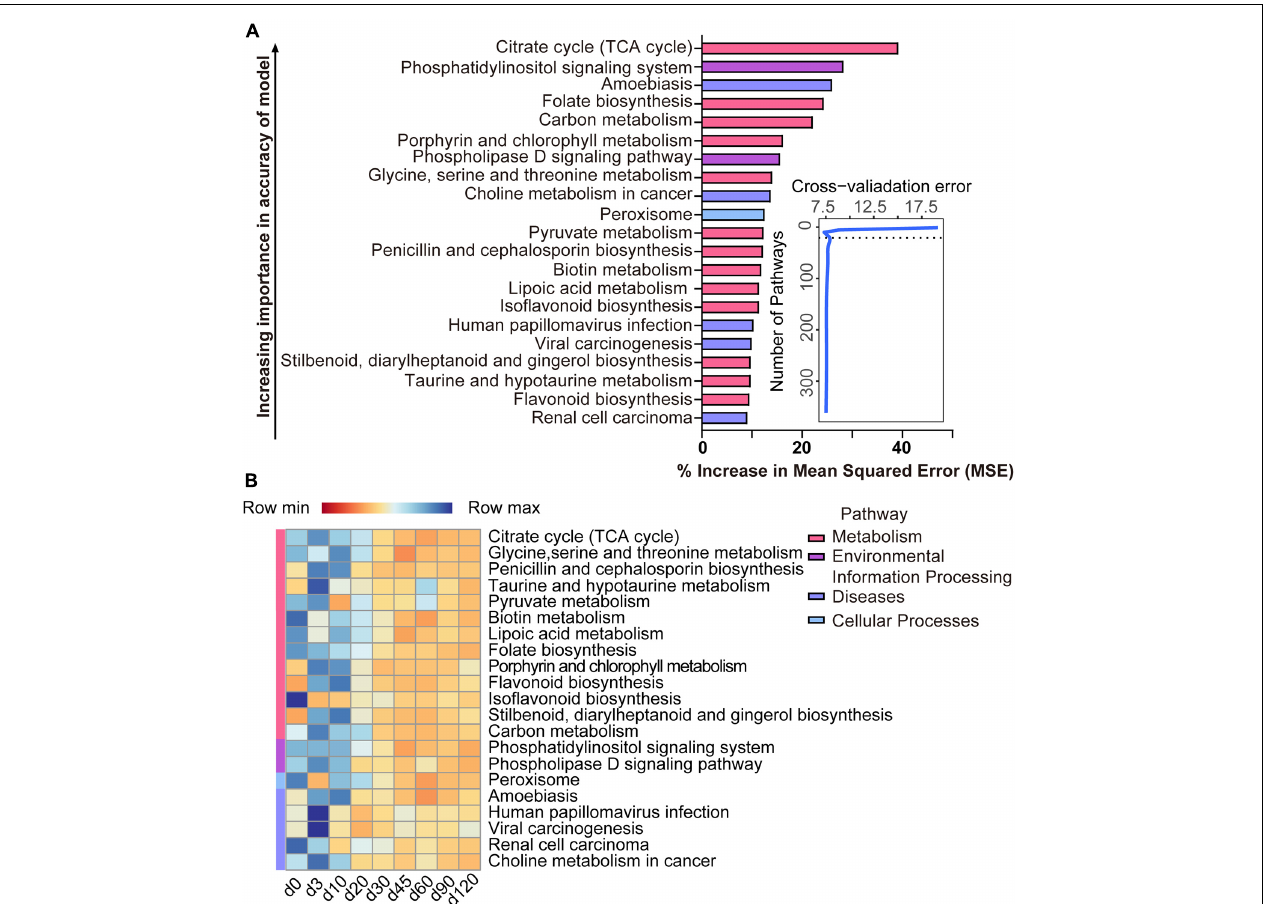
FIGURE 6 | Bacterial pathway biomarkers of lamb age and the rumen microbiota gradually stabilize. (A) The top 21 biomarkers of bacterial pathways were identified by applying RandomForest regression of their relative abundances in lambs against chronological age. Ranking in descending order of importance to the accuracy of the model was to determine biomarker taxa. The insert illustrates the result of the 10-fold cross-validation error. (B) Heatmap of changes over ages showing the relative abundances of the top 21 age-predictive biomarkers for bacterial pathways.